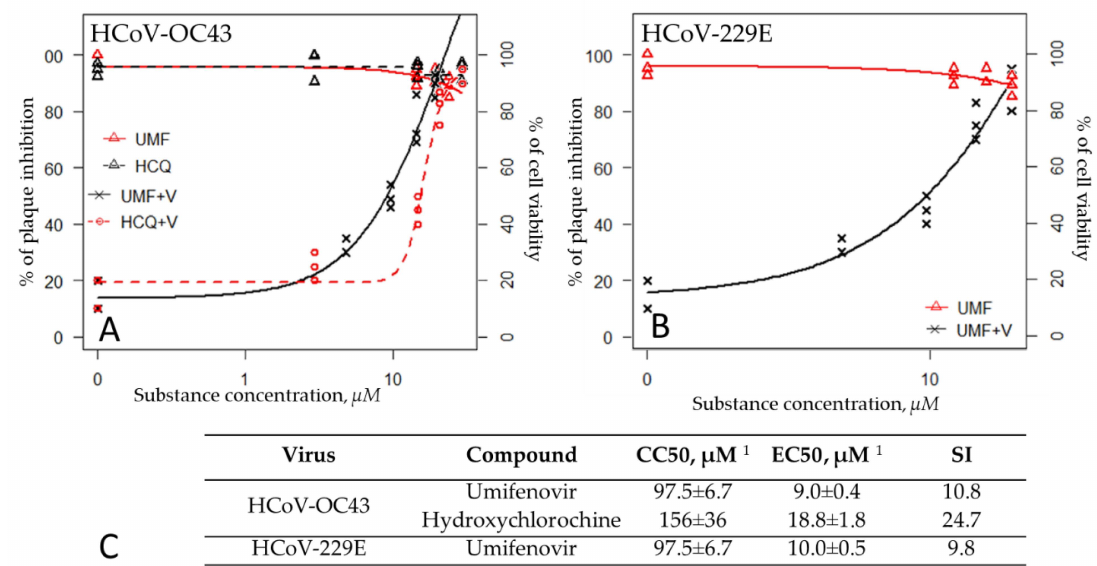
Figure 2. Antiviral activity of umifenovir against seasonal coronaviruses. Umifenovir (UMF) and hydroxychloroquine (HCQ) were added to Vero E6 cells at each concentration. The rate of cell viability (cytotoxicity control) was measured after 72 h using the MTT assay. HCoV-OC43 and HCoV-229E virus growth was determined by plaque assay 8days after infection in the presence of various concentrations of drugs. ( A ) Percent inhibition of HCoV-OC43 by umifenovir (UMF+V) and hydroxychloroquine (HCQ+V) and cytotoxicity (UMF, HCQ) in Vero E6. ( B ) Percent inhibition of HCoV-229E by umifenovir (UMF+V) and cytotoxicity (UMF) in Vero E6. ( C ) The CC50 and EC 50 values are represented as mean ± SD, and the three-parameter log-logistic (LL.3) function was used. Selectivity index (SI) was calculated as a ratio of a drug’s CC50 and EC50 values (SI = CC50/EC50). 1 CC50 and EC50 were determined from three independent